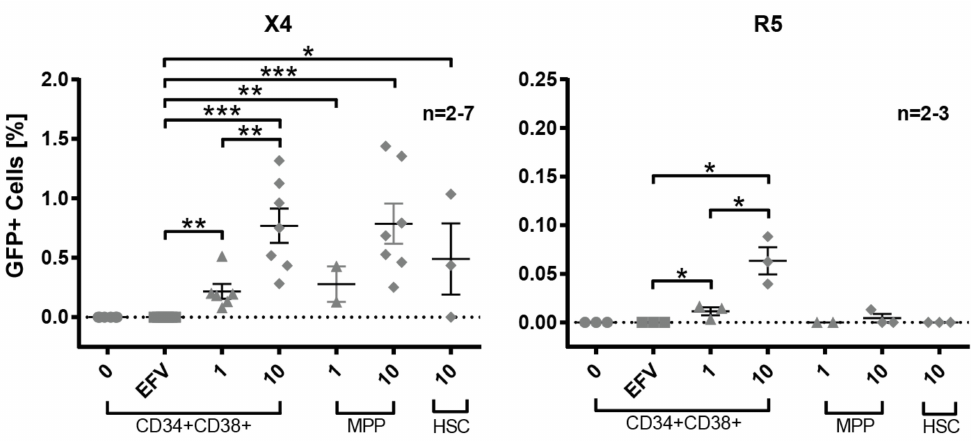
Figure 2. Transduction of bone marrow-derived sorted hematopoietic progenitor subsets with X4 and R5 HIV-1 Env-pseudotyped reporter viruses. Sorted hematopoietic progenitor subsets were transduced with GFP-expressing reporter viruses pseudotyped with X4 (HxB2, left) or R5 (JRFL, right) at different MOIs. The percentage of GFP + cells 72 h post-transduction is shown. The sorted HSPC subsets are CD34 + CD38 + progenitors, multipotent progenitors (MPP, CD34 + CD38 − CD45RA − CD90 − ) and hematopoietic stem cells (HSC, CD34 + CD38 − CD45RA − CD90 + ). Transduced cells (MOI = 10) treated with efavirenz (EFV) were used as negative control; n represents the number of different donors analyzed. The mean and standard error of the mean are indicated. Statistically significant differences to EFV-treated samples or among samples transduced with different MOIs per subset were calculated using a two-tailed t -test (* p < 0.05; ** p < 0.01; *** p <